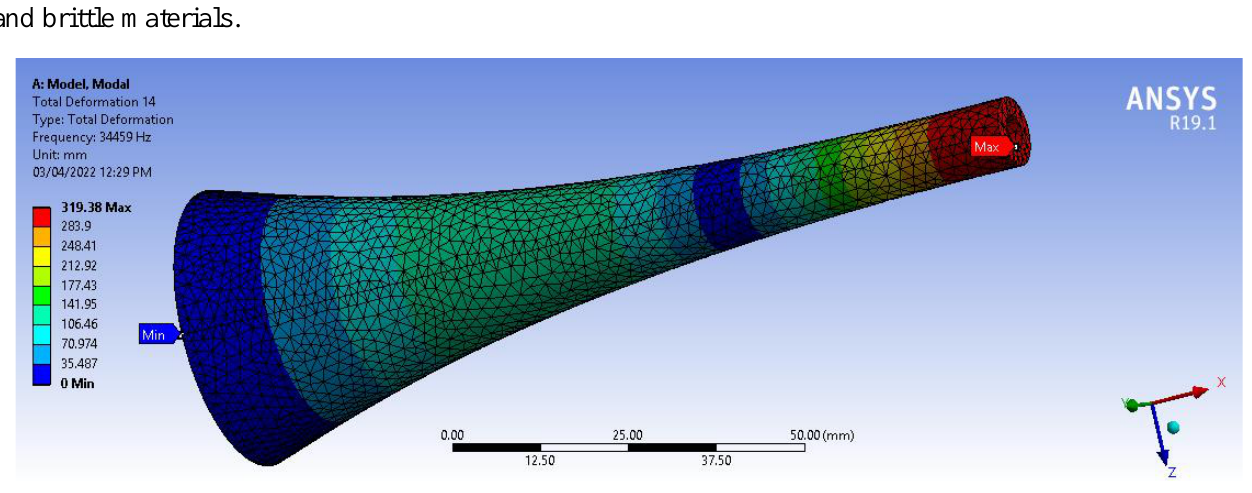
Figure 3. Resonant frequency result of aluminum horn corresponding to 2 nd axial mode